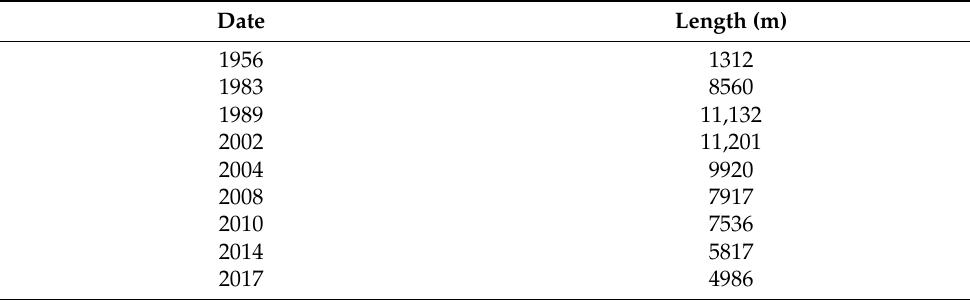
Table 3. Pathway length (m) in each analyzed image.